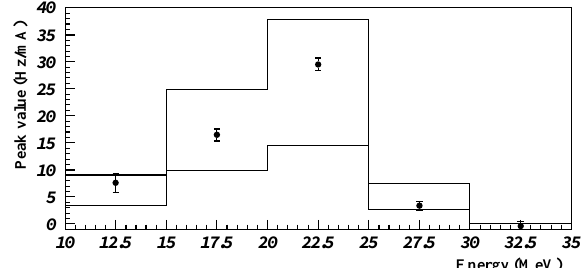
FIG. 6. The peak signal rates as a function of energy. The histogram shows the range of the expected count